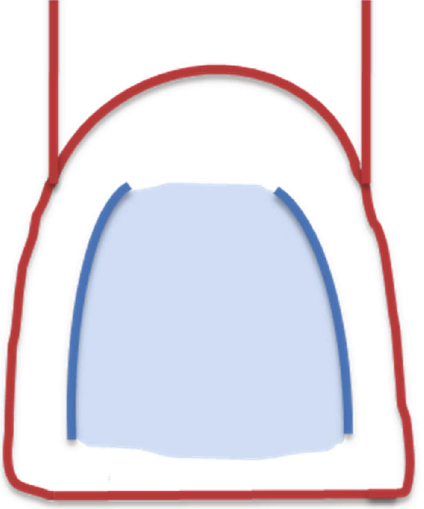
Figure 2: Tooth facial re fl exive surface bounded by mesial and distal line angles.